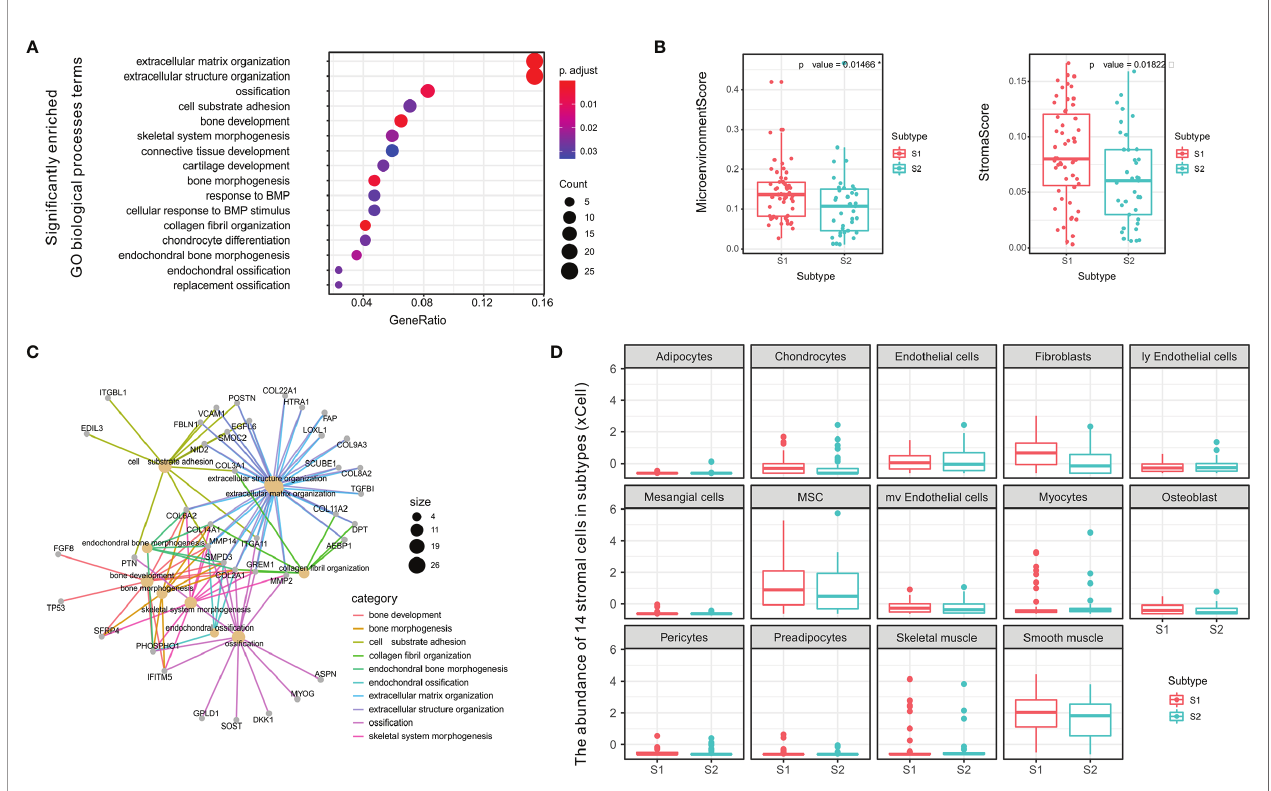
FIGURE 4 | Differences between S1 and S2 subtypes related to extracellular matrix and stromal cells in the tumor microenvironment. (A) Dot plot showing the number of genes associated with the GO BP terms (circle size) and the p-adjusted values for these terms (circle color) based on the DEG enrichment results between the two subtypes S1 and S2. (B) Category net plot showing the relationships between genes associated with the top 10 most signi fi cant GO BP terms. (C) Evaluation of the in fi ltration scores for the entire microenvironment and stromal cells between the S1 and S2 TME subtypes. (D) Boxplot displaying enrichment scores for 14 stromal cell types determined using xCell across the two subtypes. The signi fi cance levels of the p-values are presented as *p <